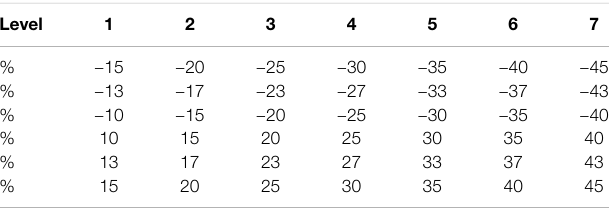
TABLE 2 | Percentages of numerical disturbance within the seven disturbance levels applied on the initial data set. Level